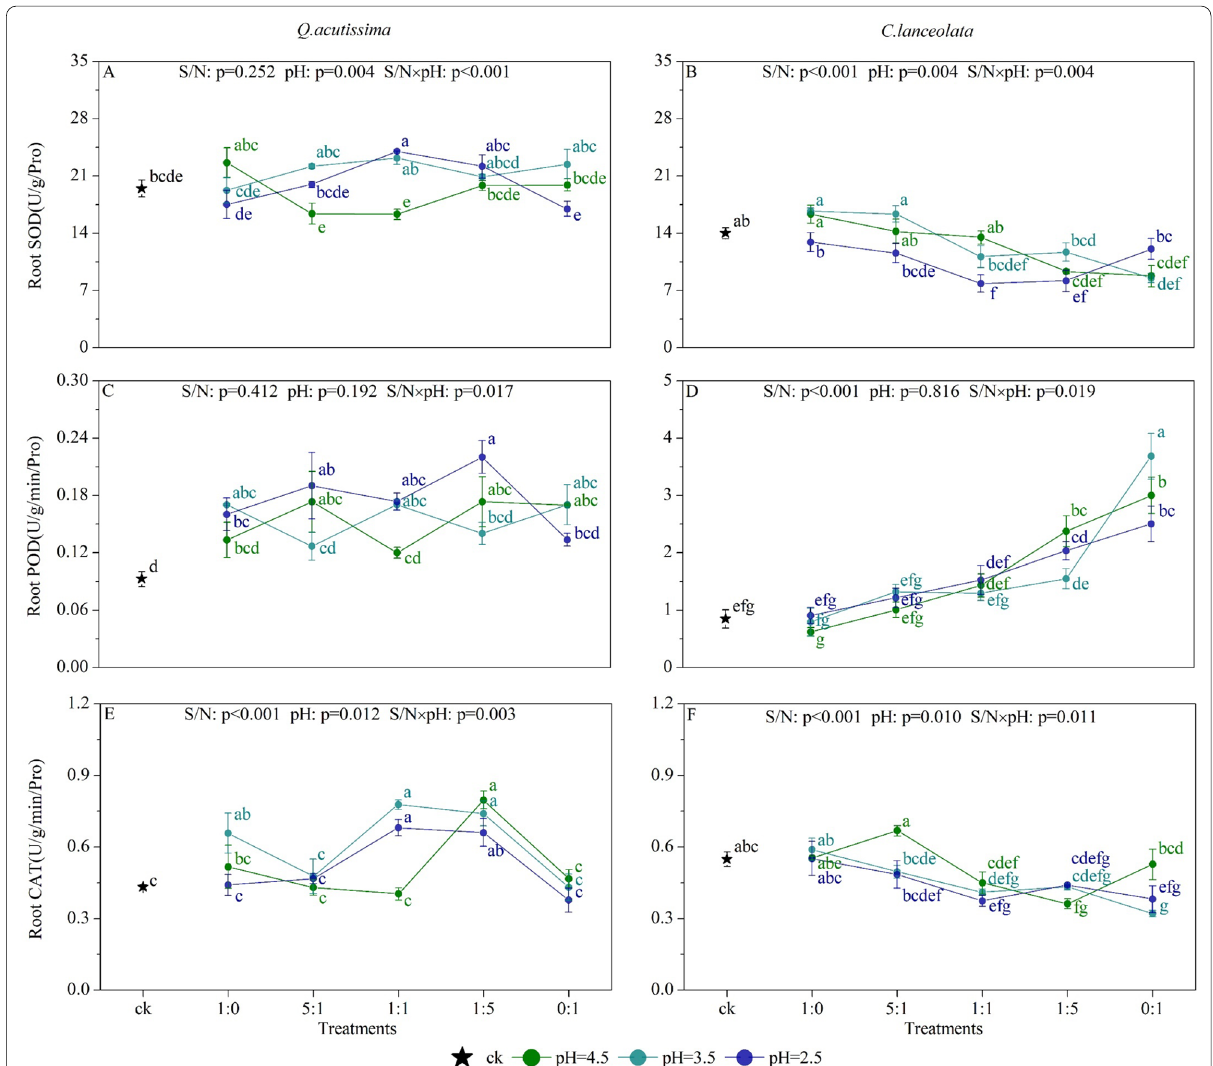
Fig. 5 Variations in the root antioxidant enzymes activities between treatments. Different ratios represent the AR S/N ratio and different colors represent the AR pH. The analysis and meaning of the letters are consistent with Fig.